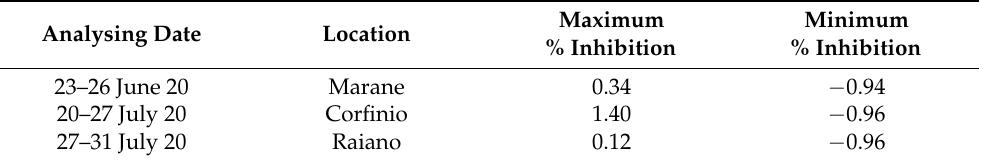
Table 3. ATOX monitoring data.